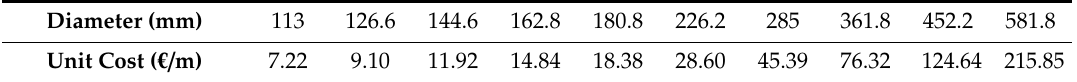
Table 3. Unit costs of Balerma network.